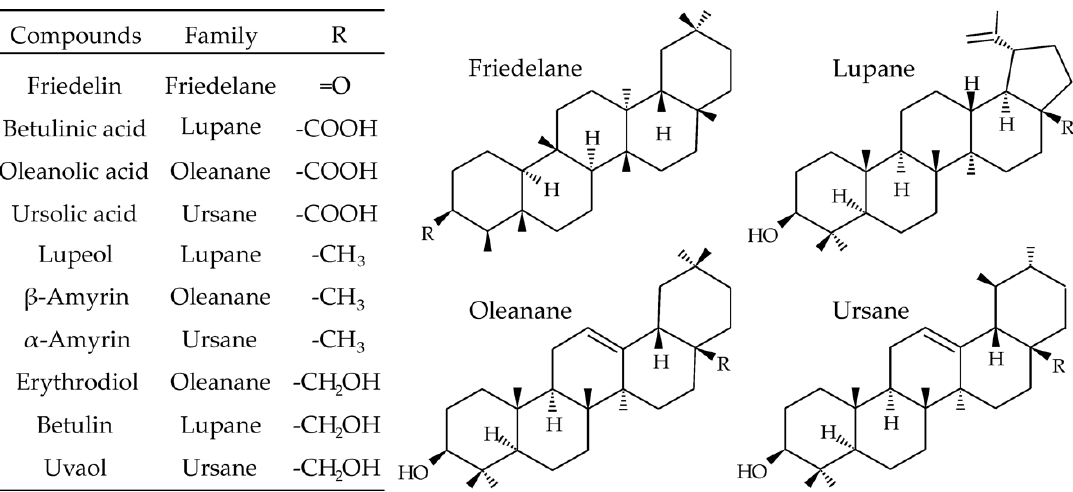
Figure 1. Chemical structure of the studied pentacyclic triterpenoids.